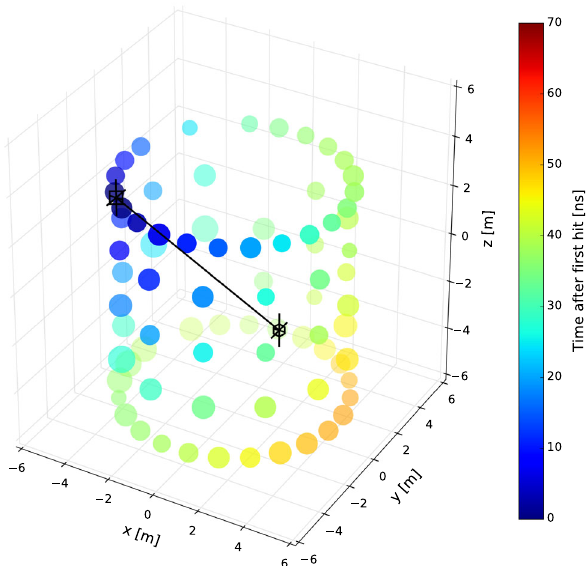
Fig. 15 The arrival time information of light in the PMTs of the muon veto detector (color coded points) allows the approximate reconstruc- tionofthemuontrack(blackline)thoughthewatershield.Thisexample shows an event where the muon traversed the shield close but next to the